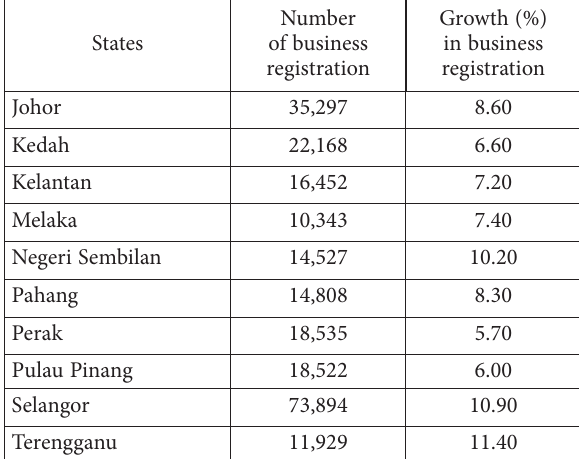
Table 2. Average of total number and average annual growth rate of business registration in a set of Malaysian states (2000– 2017) (source: Companies Commission of Malaysia,